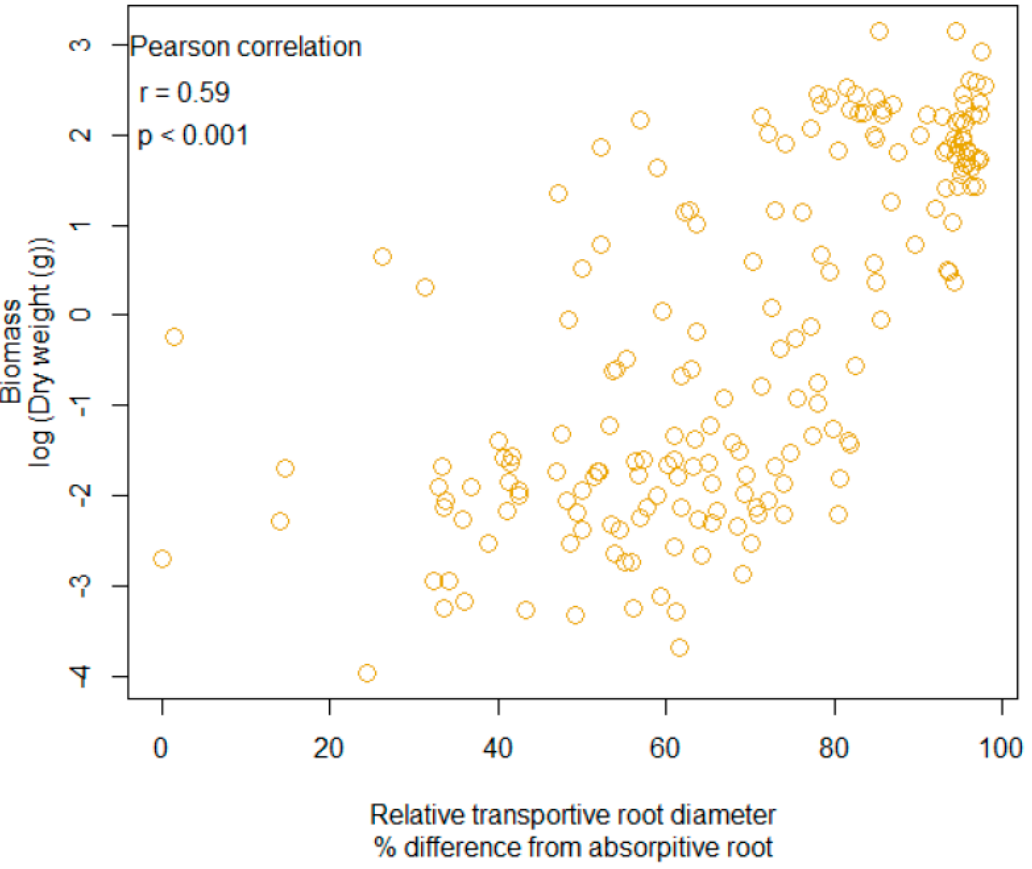
Figure 3. The relationship with biomass and relative root diameter. Each point represents an individual plant from the experiment.